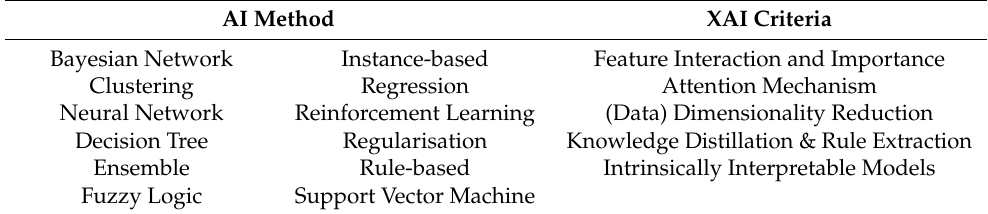
Table 4. AI Methods and XAI Criteria used for the systematic analysis of the literature.